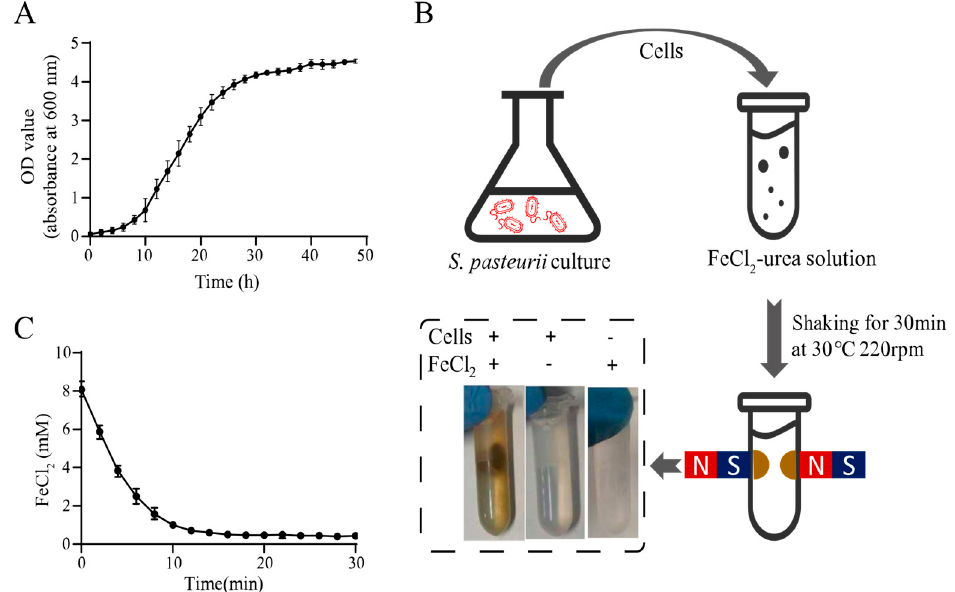
Figure 1. Magnetic microbial-induced precipitation (MIP) induced by whole cells of Sporosarcina pasteurii . ( A ) Growth curve of S. pasteurii. ( B ) Schematic diagram of magnetic MIP induced by S. pasteurii . ( C ) Curve of residual FeCl 2 in the supernatant during magnetic MIP. All values were determined in three independent biological replicates.